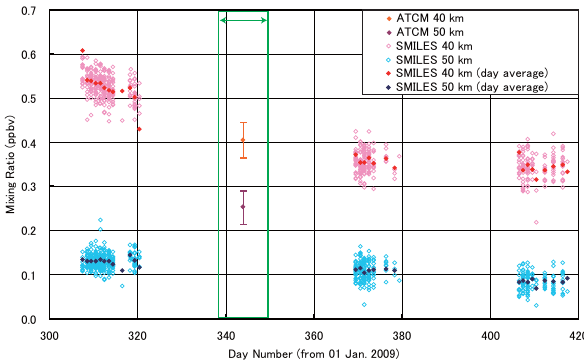
Fig. 9. The ClO mixing ratio at 40km and 50km obtained by JEM/SMILES (ver. 1.3) and NATAOS radiometer between Novem- ber 2009 and February 2011. The SMILES data were selected within ± 2 ◦ in latitude and ± 30 ◦ in longitude from Atacama and with an observational time of 12:00–15:00LT. Pink and light blue open circles show the ClO mixing ratio obtained by SMILES at 40km and 50km, respectively. Red and blue circles show daily av- erage of ClO mixing ratio obtained by SMILES at 40km and 50km, respectively. Orange and purple circles show the ClO mixing ratio obtained by NATAOS radiometer at 40km and 50km, respectively. The arrow shows the period of averaging NATAOS data, from 5 to 16 December 2009.